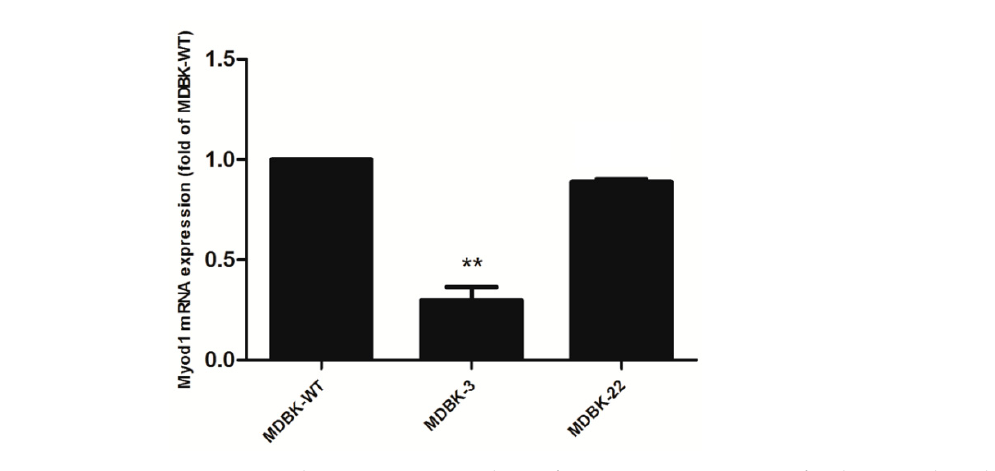
Figure 1. Sequencing results for 4 MyoD1 gene disruptions using sgRNA6.